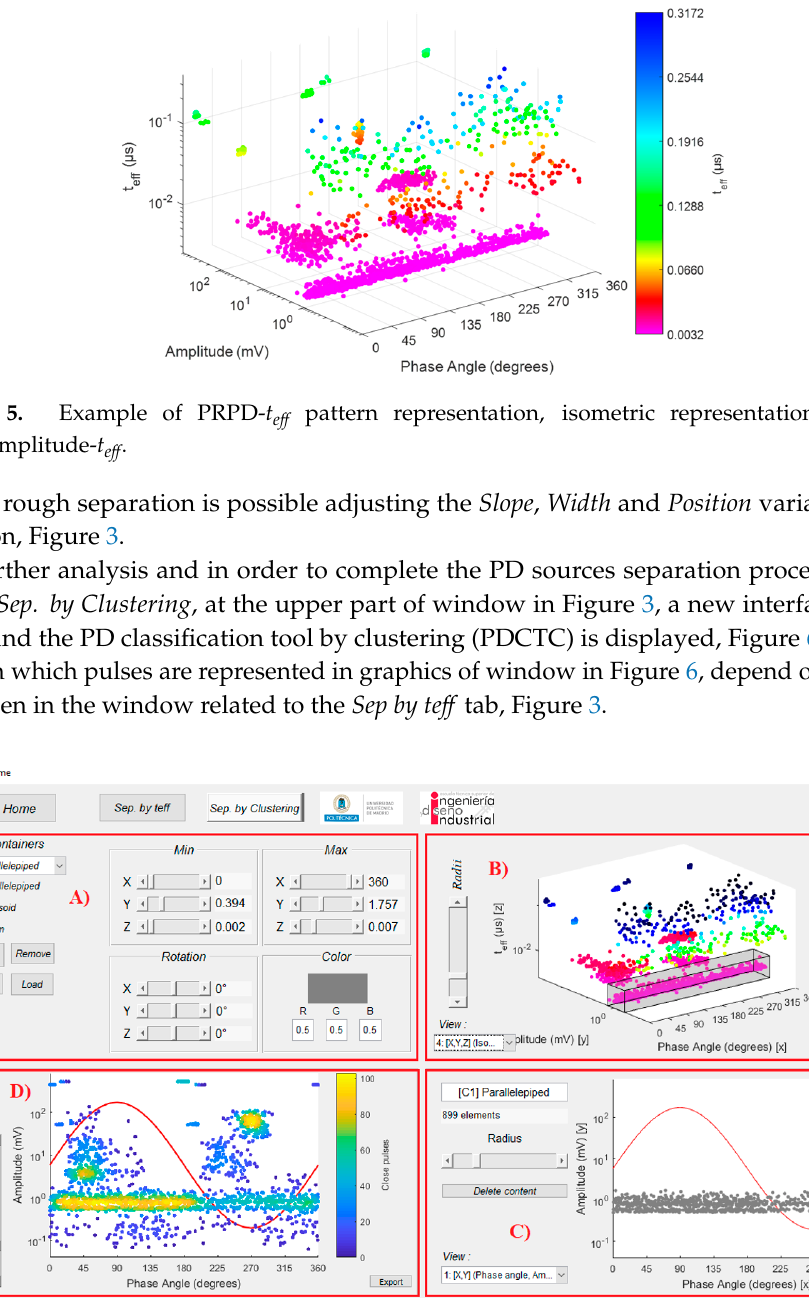
Figure 5. Example of PRPD- t eff pattern representation, isometric representation of phase angle- amplitude- t eff .